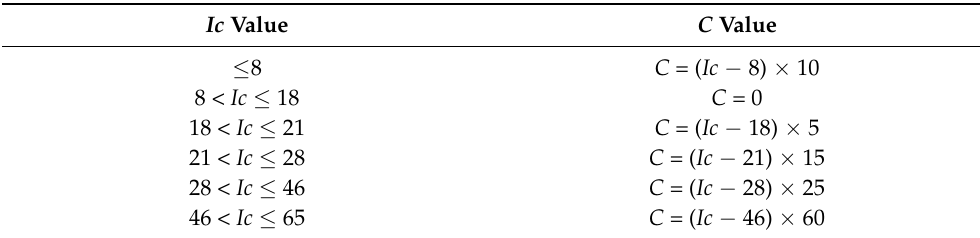
Table 1. Calculation of the compensation value of C for the calculation of ITC (Compensated thermicity index), based on the Ic value.